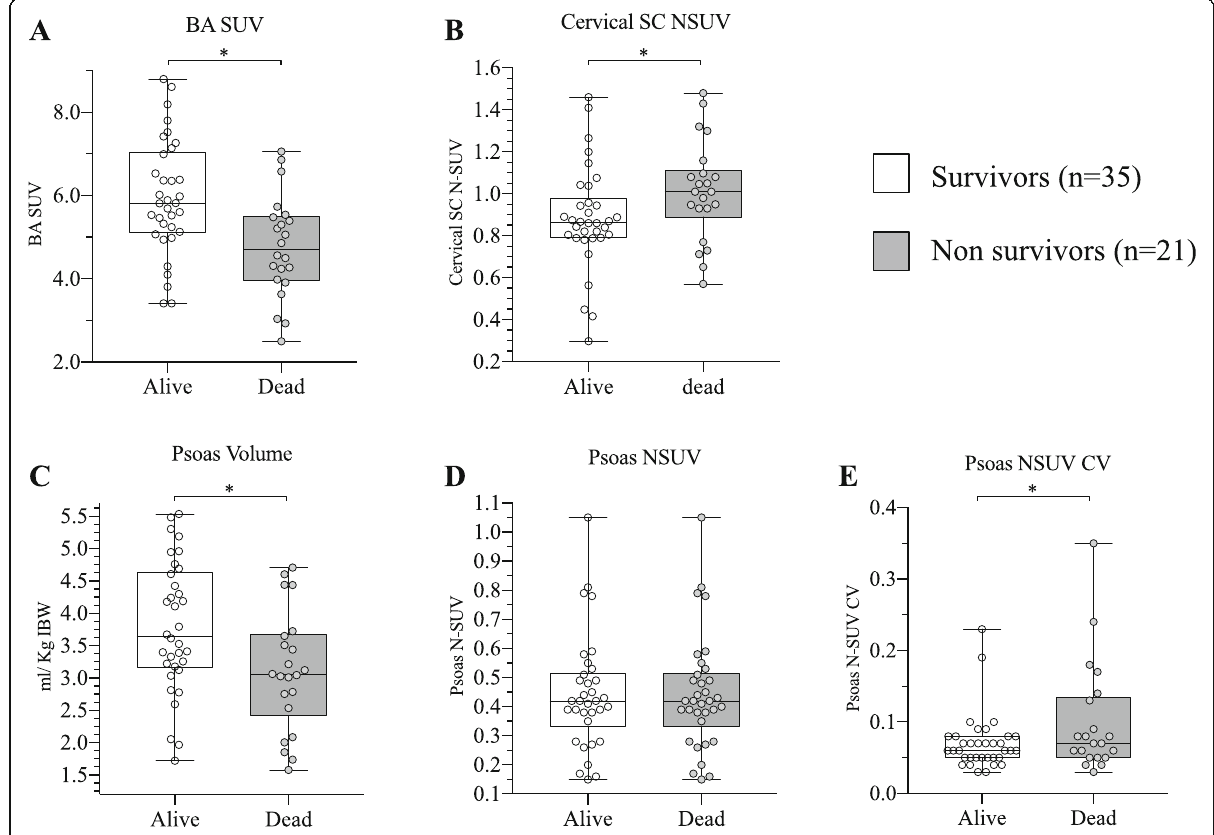
Fig. 3 FDG uptake in BA4, spinal cord and psoas muscle in ALS according to patient outcome. Long-term survival was associated with a higher FDG accumulation in BA4 ( a ) and a lower FDG uptake in the cervical spinal cord ( b ). Psoas muscle showed a similar FDG uptake in the two subgroups ( d ) but greater homogeneity of tracer retention ( e ) and higher volumes ( c ) in survivors. * p < 0.05 vs